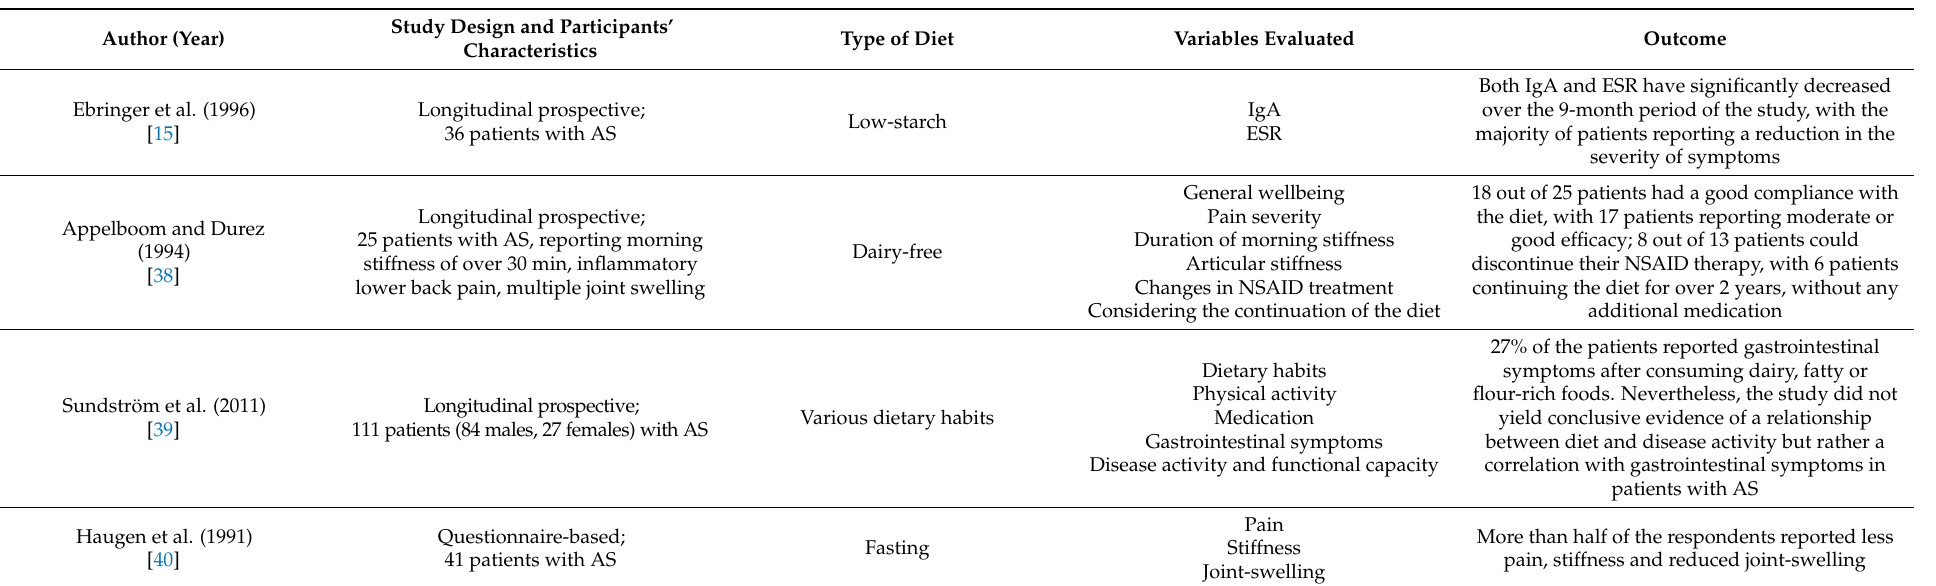
Table 1. Studies analysing the impact of different diets in patients with